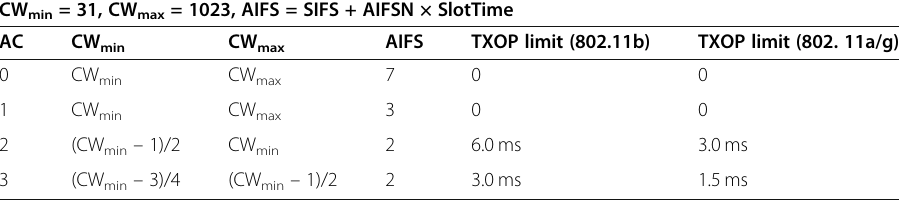
Table 2 EDCA default parameters [20, 22]